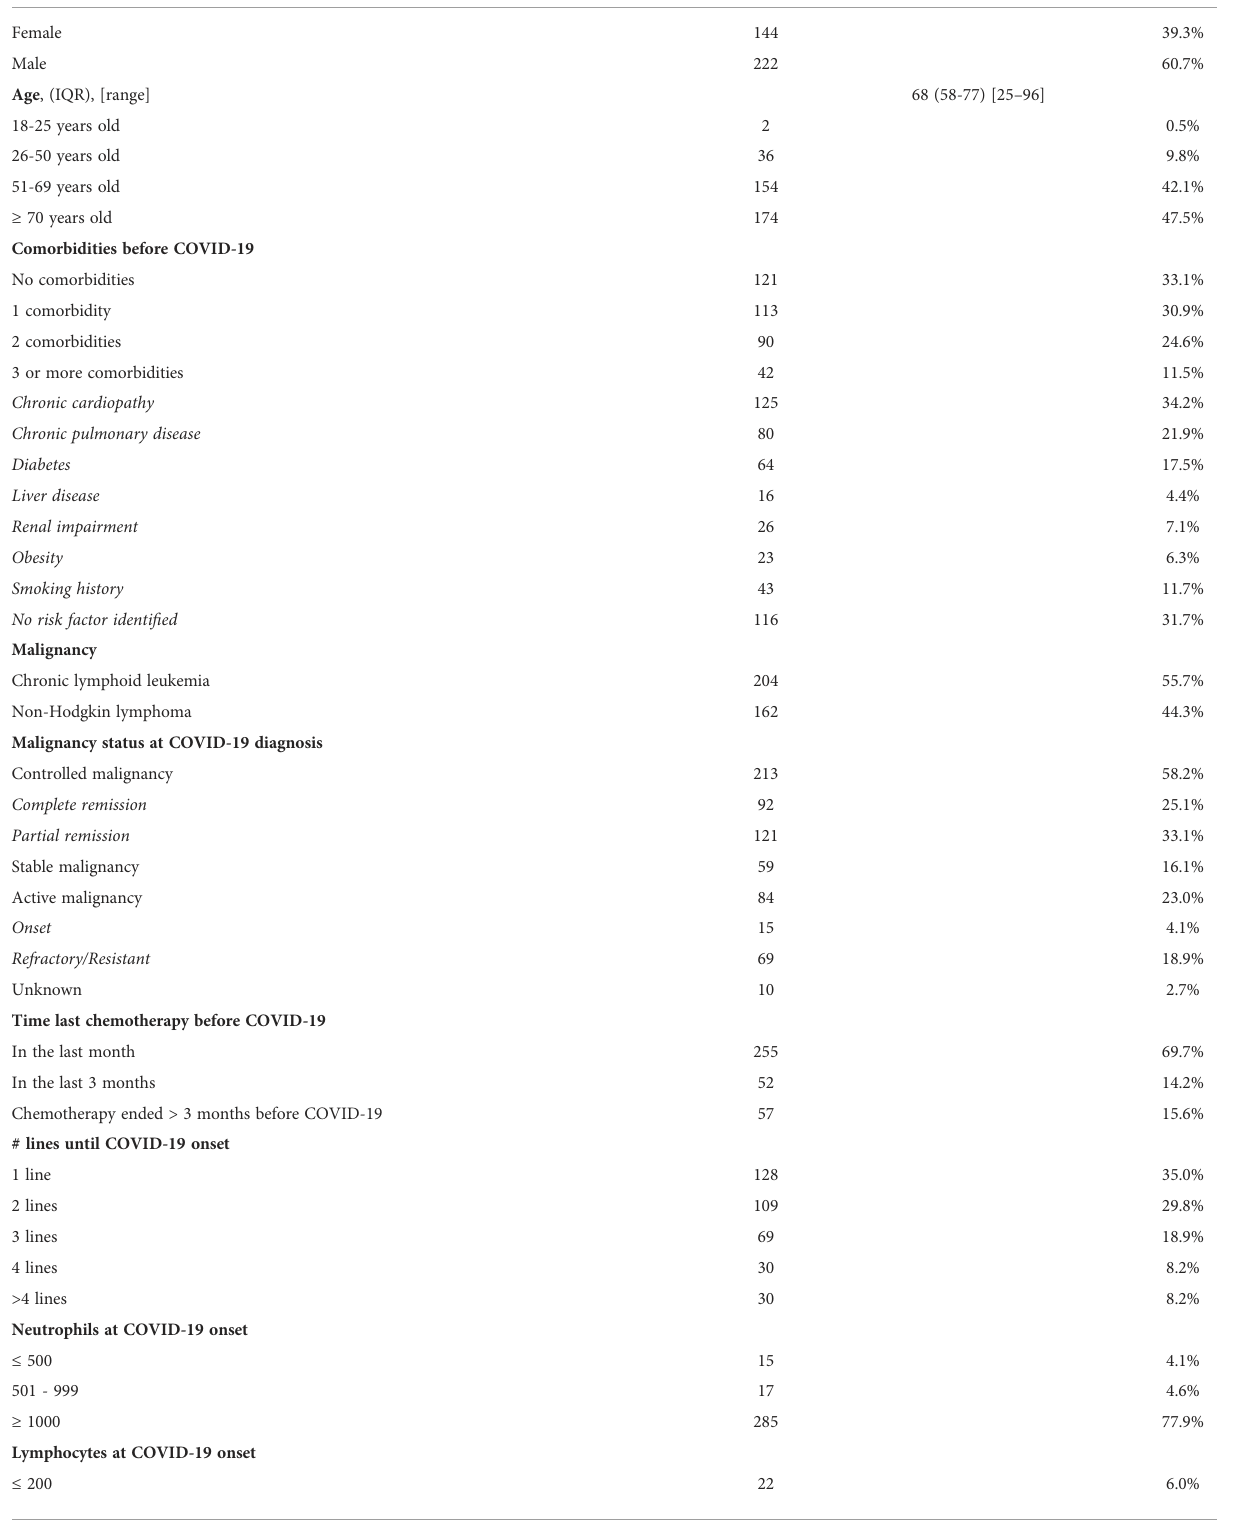
TABLE 1 Patients ’